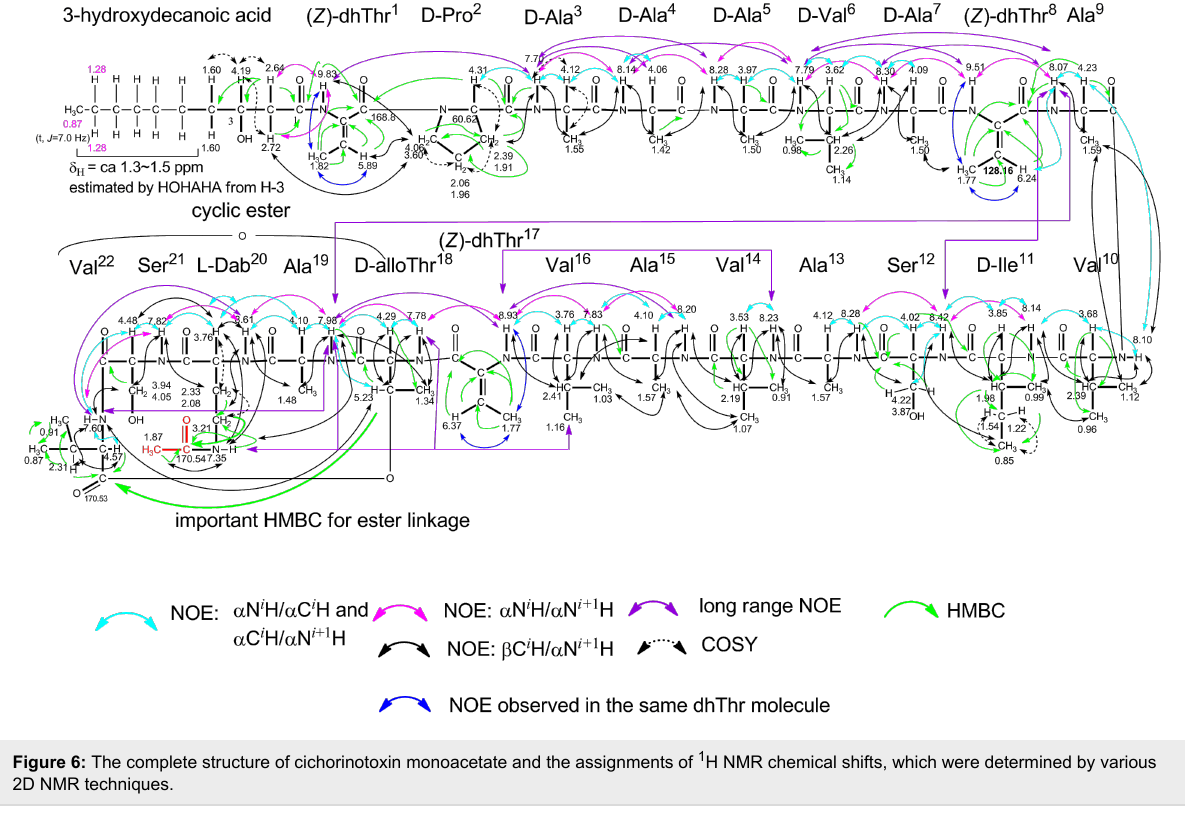
Figure 6: The complete structure of cichorinotoxin monoacetate and the assignments of 1 H NMR chemical shifts, which were determined by various 2D NMR techniques.